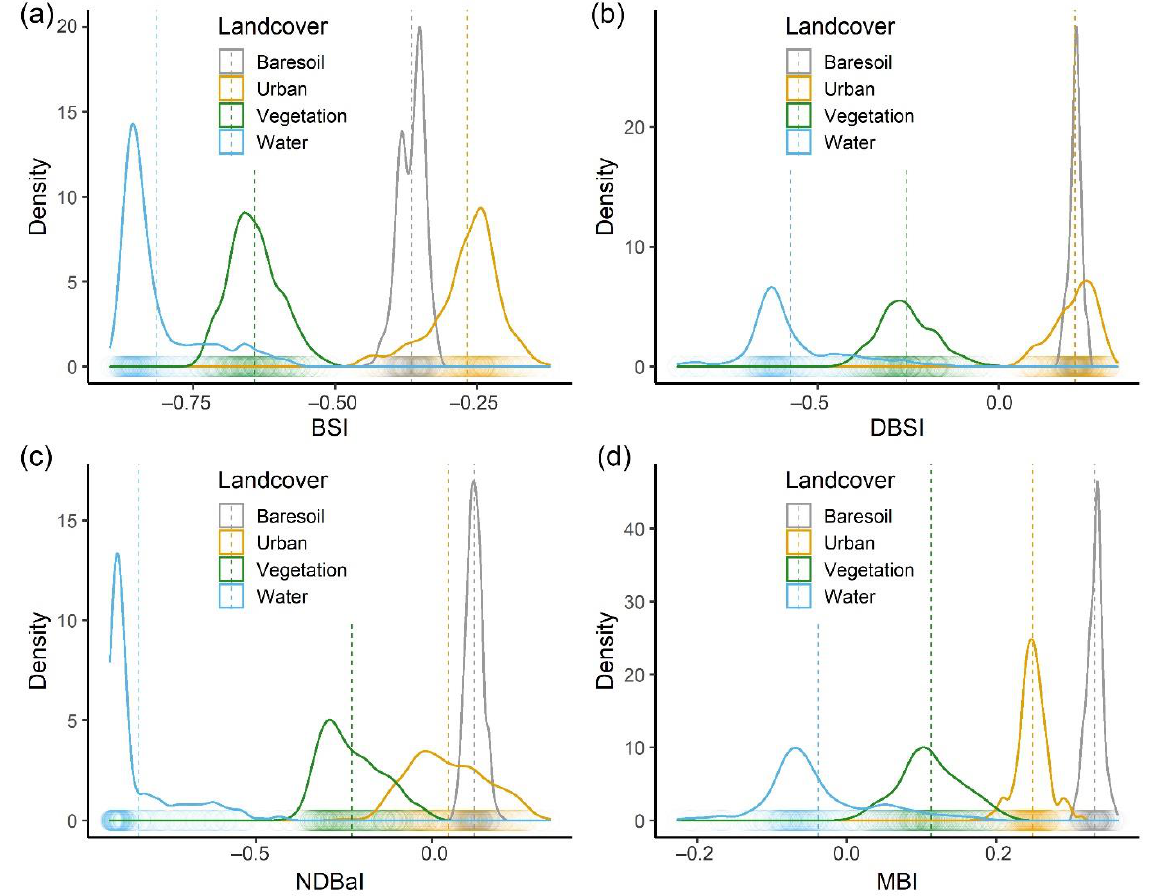
Figure 6. The density graph illustrates the density distribution of four land cover types for ( a ) bare soil index (BSI), ( b ) normalized difference bareness index (NDBaI), ( c ) dry bare-soil index (DBSI), and ( d ) modified bare soil index (MBI). Dash lines present mean values, and darker zones on horizontal show more concentrated data zones.